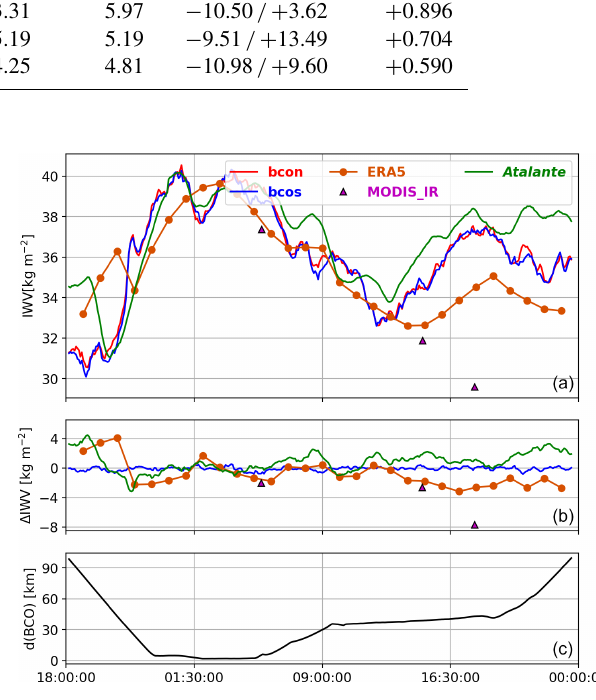
Table 5. Comparisons of ERA5 and MODIS_IR IWV with respect to ship-borne GNSS estimates: N IWV – number of IWV comparisons, mean, standard deviation, rms, minimum and maximum of IWV differences (ERA5 or MODIS_IR minus GNSS), and correlation coefficient. N IWV Mean diff. SD diff. rms diff. min / max Corr. coef. (kgm − 2 ) (kgm − 2 ) (kgm − 2 ) (kgm − 2 ) ERA5 − GNSS Atalante 762 − 1.62 2.22 2.75 − 8.46 / + 4.79 + 0.954 Maria S. Merian 646 + 2.82 5.74 6.39 + 0.787 Meteor 789 + 0.65 MODIS_IR − GNSS Atalante 56 Meteor 64 + 0.590